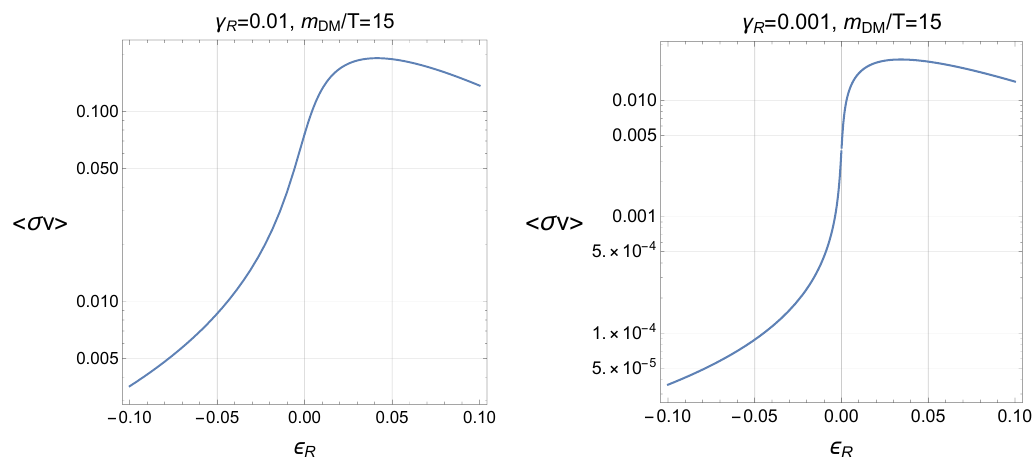
Figure 1 . Thermal-averaged 2 ! 2 annihilation cross section near resonance as a function of (cid:15) R . Here, the cross section is given in arbitrary unit, so only the relative ratio at di(cid:11)erent values of (cid:15) R is